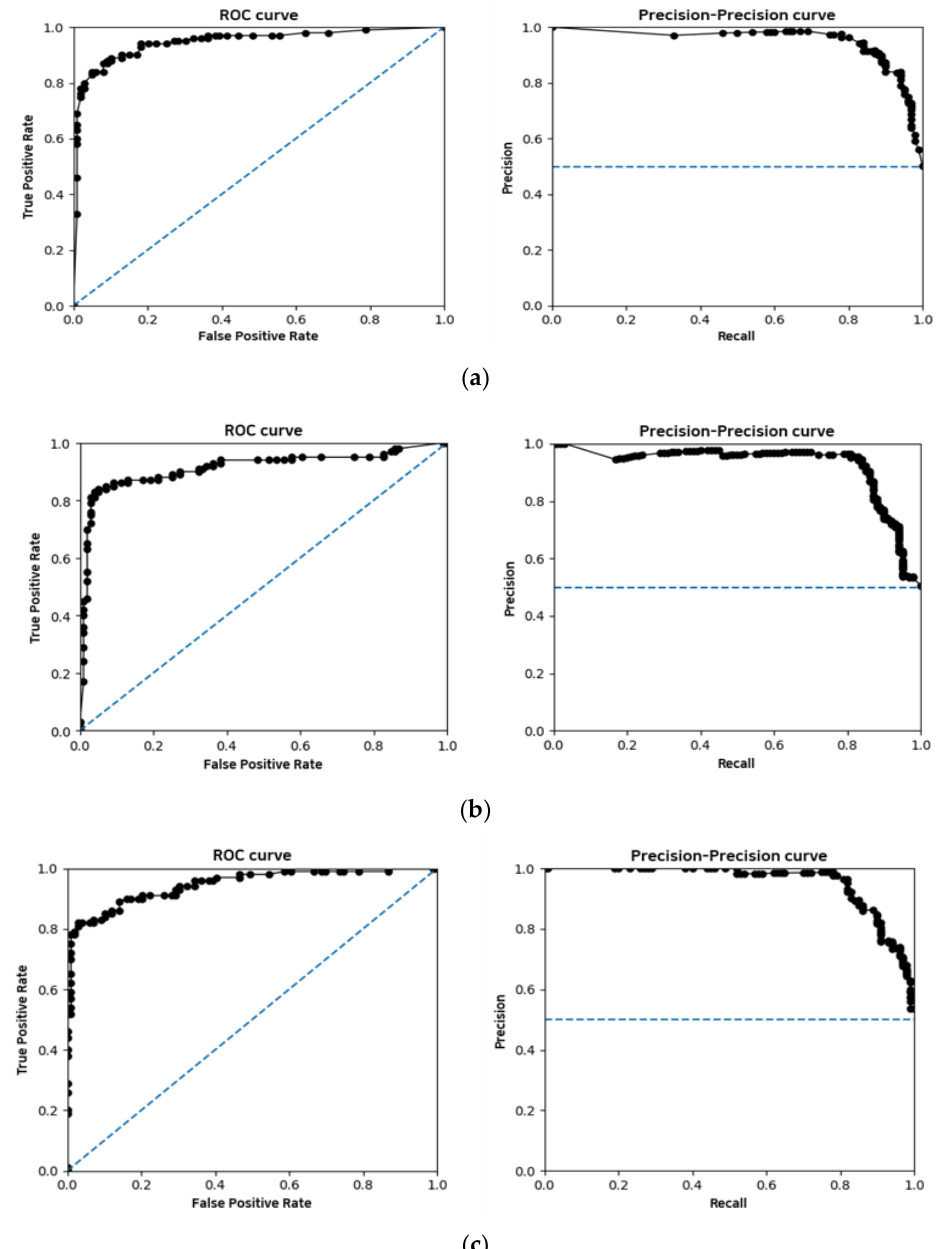
Figure 7. ROC and PR curve for each detection model. ( a ) ROC and PR curve of the Faster R-CNN;